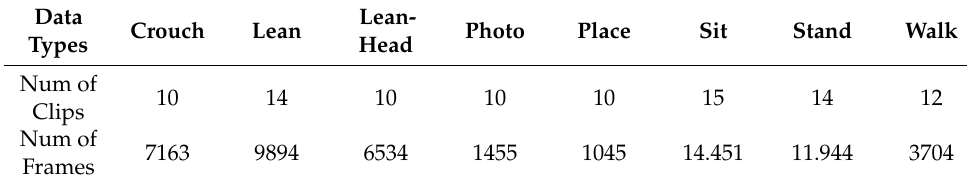
Table 5. Data distribution of 8 action classes in the private CCTV training dataset.